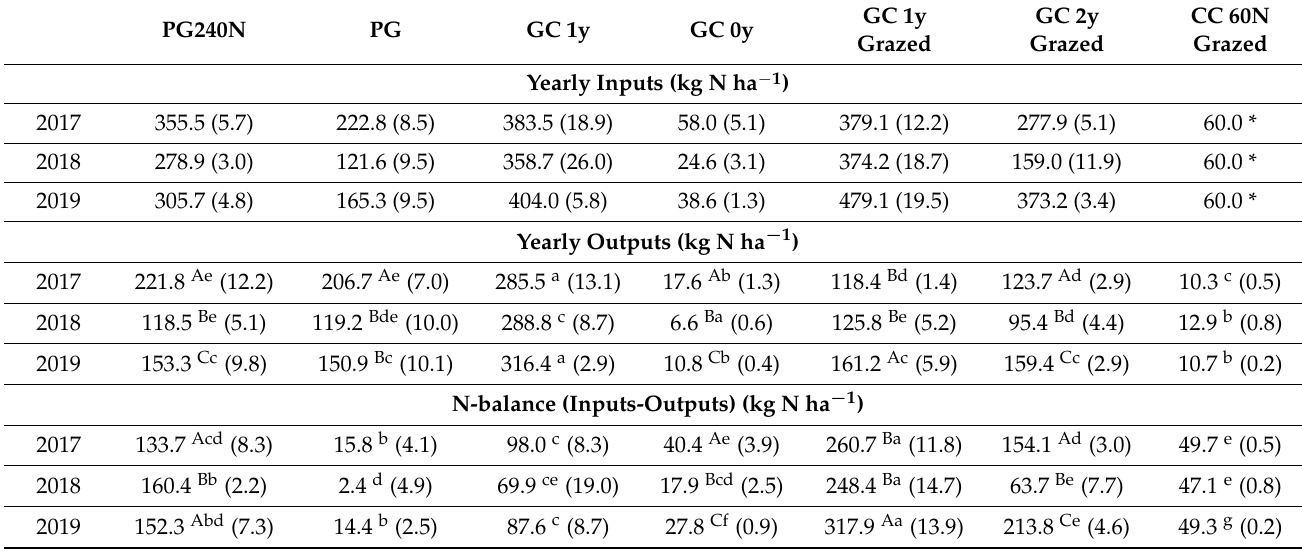
Table 5. The N-balance of the different sward types investigated over the three years (2017, 2018 and 2019). Different upper-case letters indicate significant inter-annual differences. Different lower-case letters indicate significant differences between the various sward types. SEM are shown in brackets.